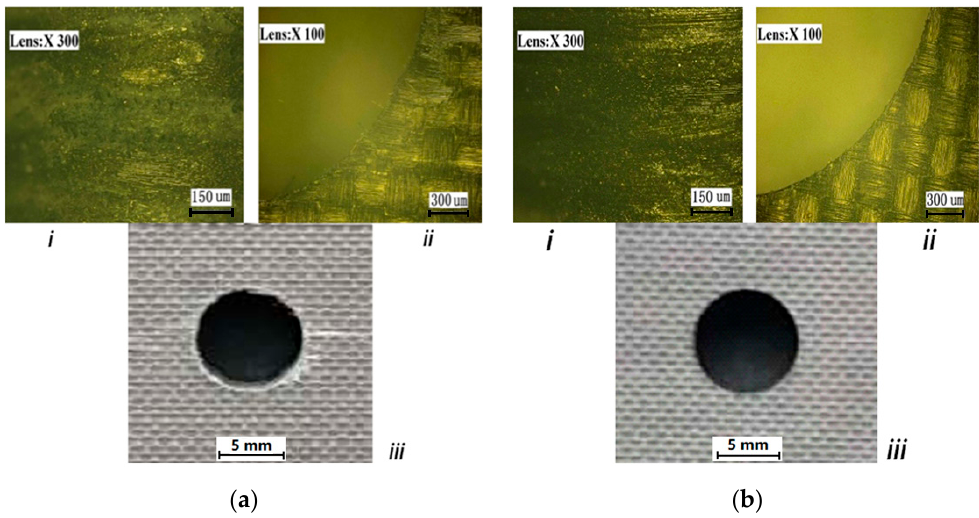
Figure 10. Surface topography of CFRP samples: ( a ) sample No. 155; ( b ) sample No. 158. i—interior surface morphology; ii—edge morphology; iii—exit appearance.